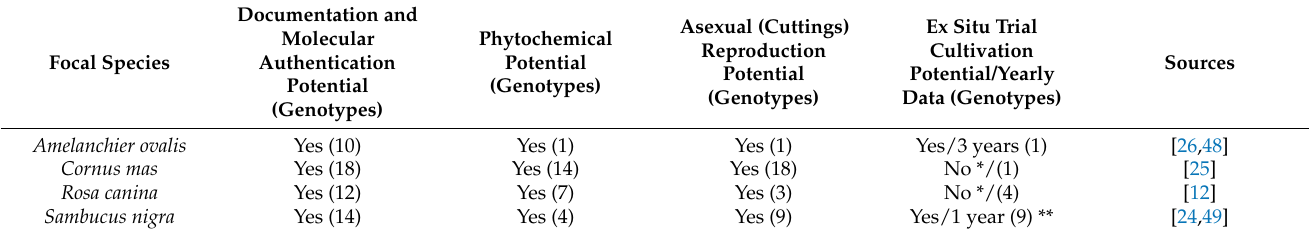
Table 3. Overview of extant documentation regarding the multifaceted potential (documentation and molecular authentication, phytochemical potential of fruits, asexual propagation potential via rooting of cuttings, and ex situ trial cultivation potential) of the selected Greek native, neglected, and underutilized germplasm (genotypes) and contribution of the current study in dataset completion per focal